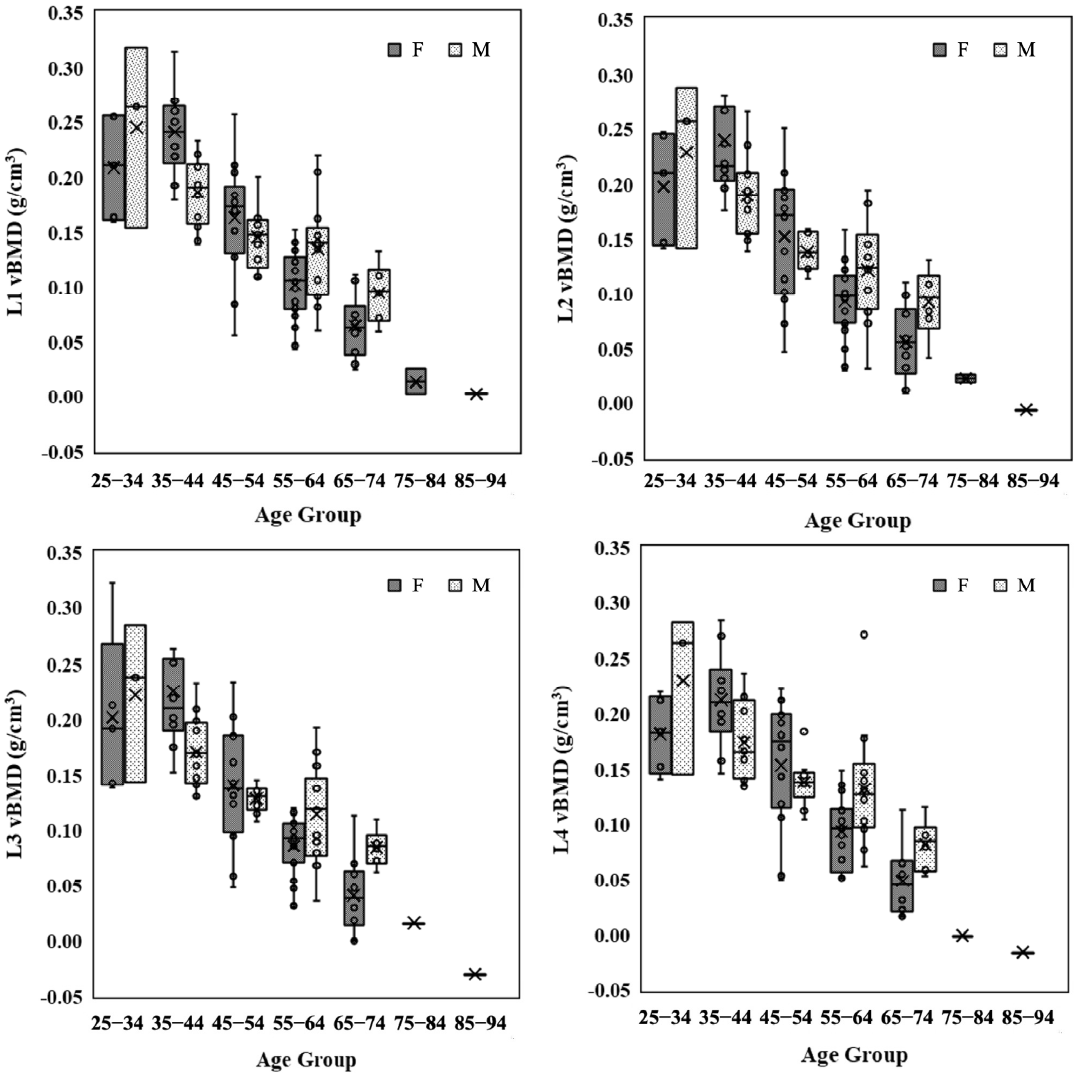
Figure 6. Relationships between vBMD and age group for different lumbar vertebrae. vBMD shows a downward year-by-year trend with increase in age for men (M) and women